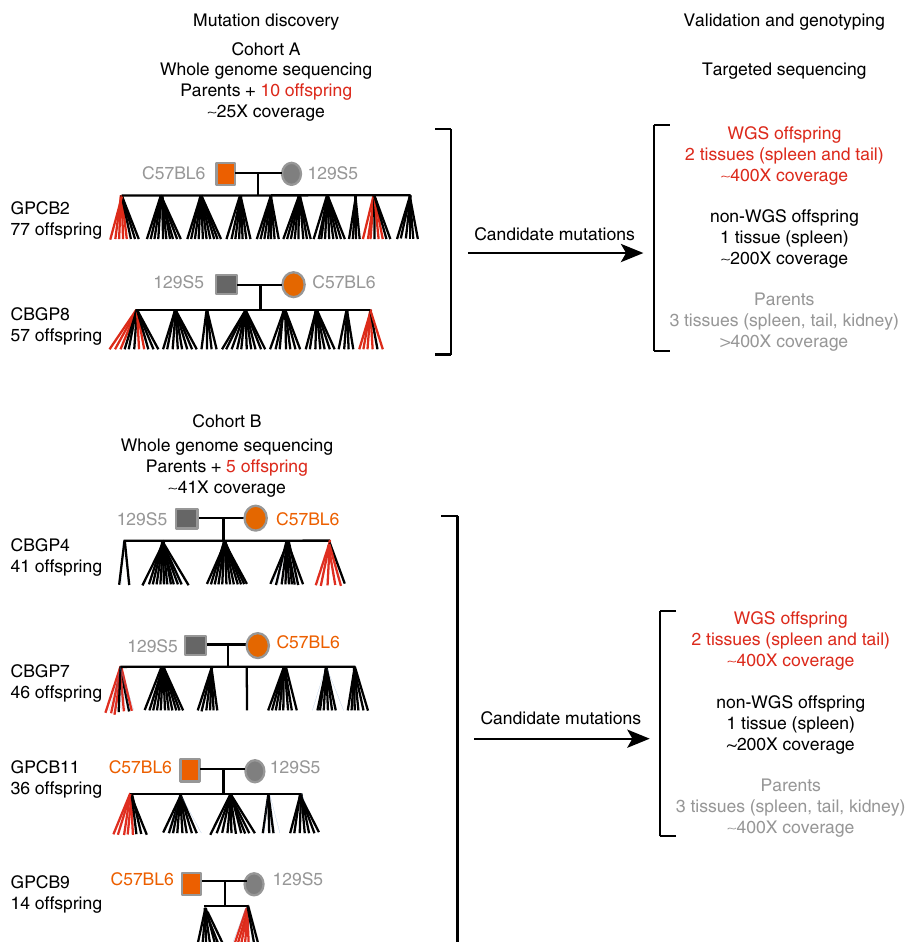
Fig. 1 Mouse pedigree sequencing and genotyping strategy. Six reciprocal crosses were established and successively mated, generating six pedigrees comprising between 41 and 77 offspring. The pedigrees shown here only include the sequenced and genotyped individuals. Three tissues (spleen, kidney and tail) were collected from all mice. Whole-genome sequencing (WGS) was performed on spleen-derived DNA for fi ve or ten pups within each pedigree (shown in red). Candidate DNMs were identi fi ed and validated using deeper targeted sequencing of 1 – 3 tissues per individual across the offspring shown. The naming conventions and differences between data collection and analysis are shown. Not all offspring from each pedigree were